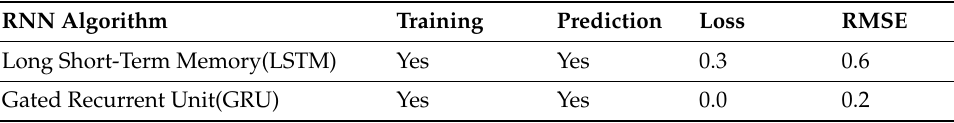
Table 8. Comparative analysis of RNN